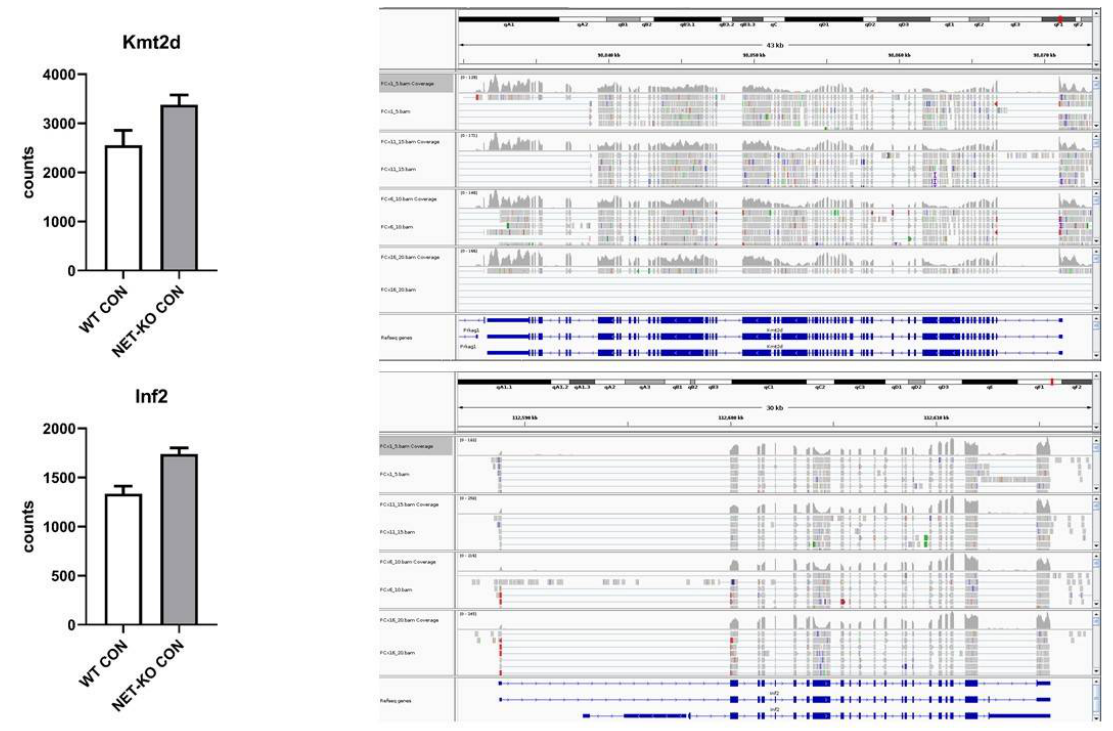
Figure 5. The expression of selected transcripts that were regulated by mmu-let-7e-5p in the prefrontal cortex of wild-type (WT) and norepinephrine transporter knock-out (NET-KO) mice under the control condition, as shown by NGS analysis. The graphs show the number of RNA-seq reads (Counts) overlapping a given gene. The right panels present the suitable RNA-seq tracks (two samples per group) that were inspected using the IGV viewer. The gene structures and annotations were obtained from the Ensembl database.